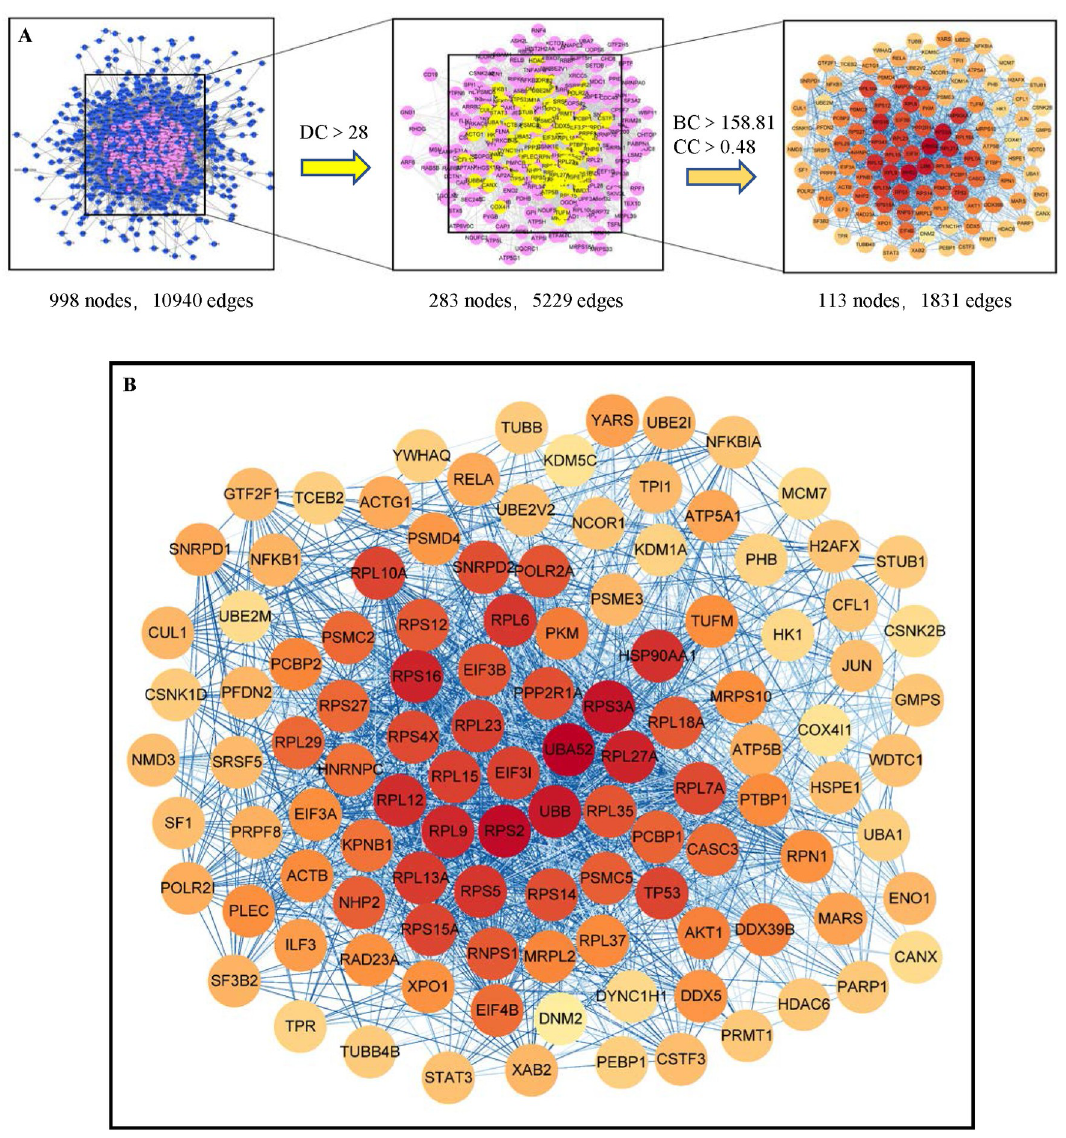
Fig 4. Protein-Protein Interaction (PPI) network of genes from the blue module. (A) Screening of hub genes. The screening criteria were degree centrality > 28, betweenness centrality > 158.81, and closeness centrality > 0.48. (B) Core PPI network with 113 hub genes and 1831edges. The color of the nodes represented the value of degree. The darker (red) the color, the higher the degree.